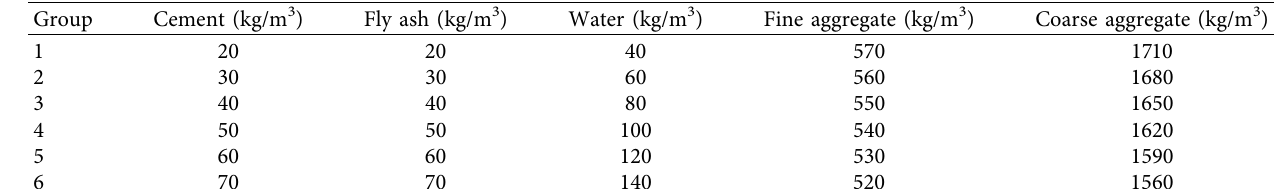
Table 2: Proportions of cementitious material.